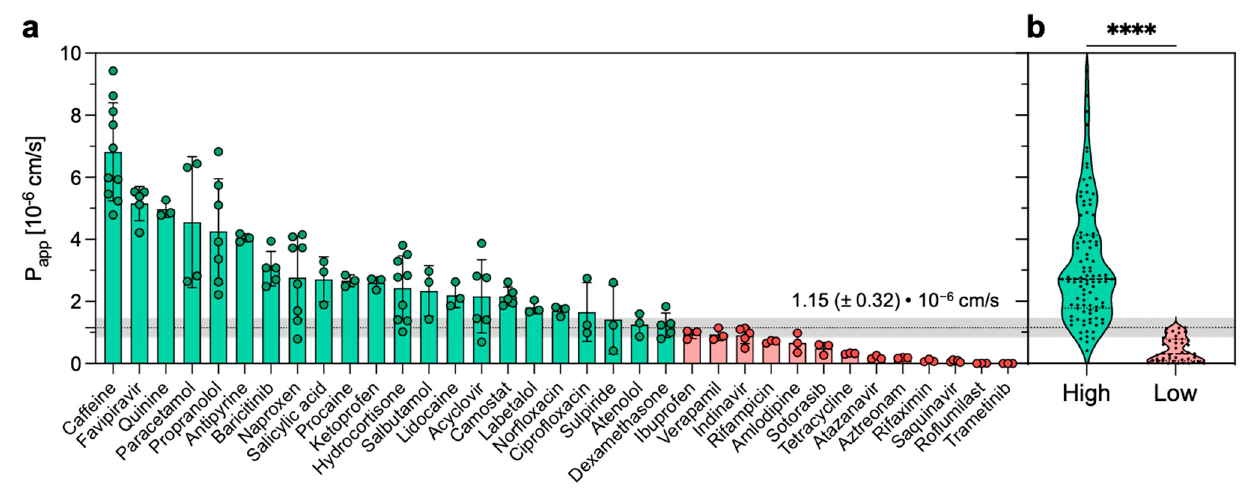
Figure 3. Apparent permeability ( P app ) of the dataset. ( a ) The dataset is classified using a binary classification (high/low) according to the P app . The threshold was set at 1.15 (± 0.32) × 10 − 6 cm/s. ( b ) Student’s t -test was used to test the statistical significance between the high- and low-permeable groups (* p < 0.05, ** p < 0.01, *** p < 0.001, **** p < 0.0001).